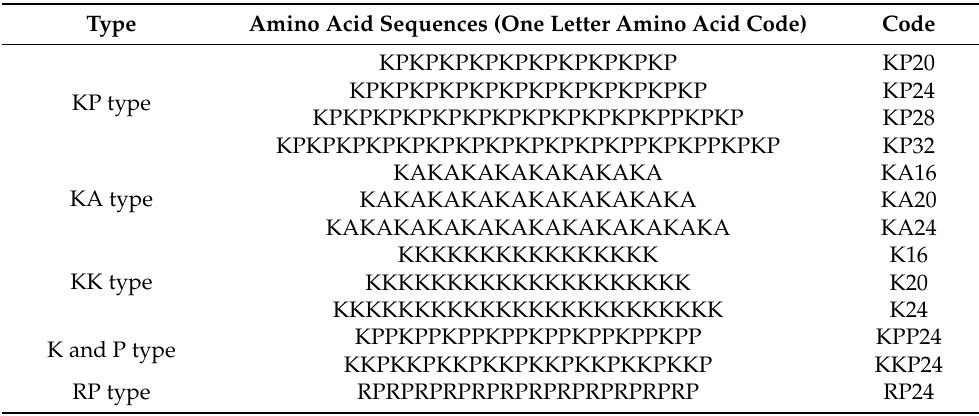
Table 1. Peptide sequence of designed